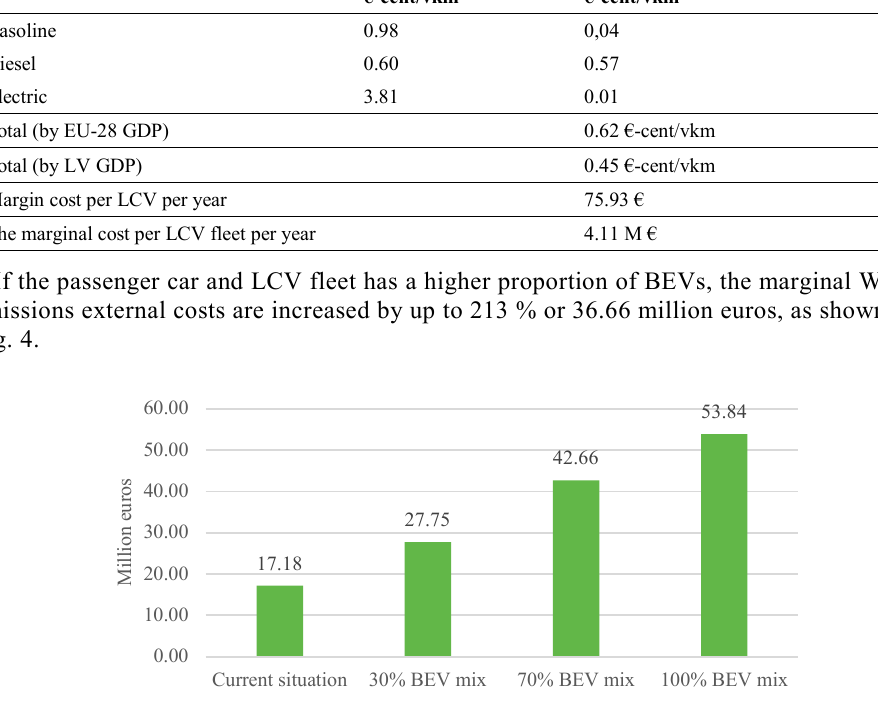
Fig. 4. Yearly WTT external costs with different BEV proportions in Latvia’s passenger car and LCV